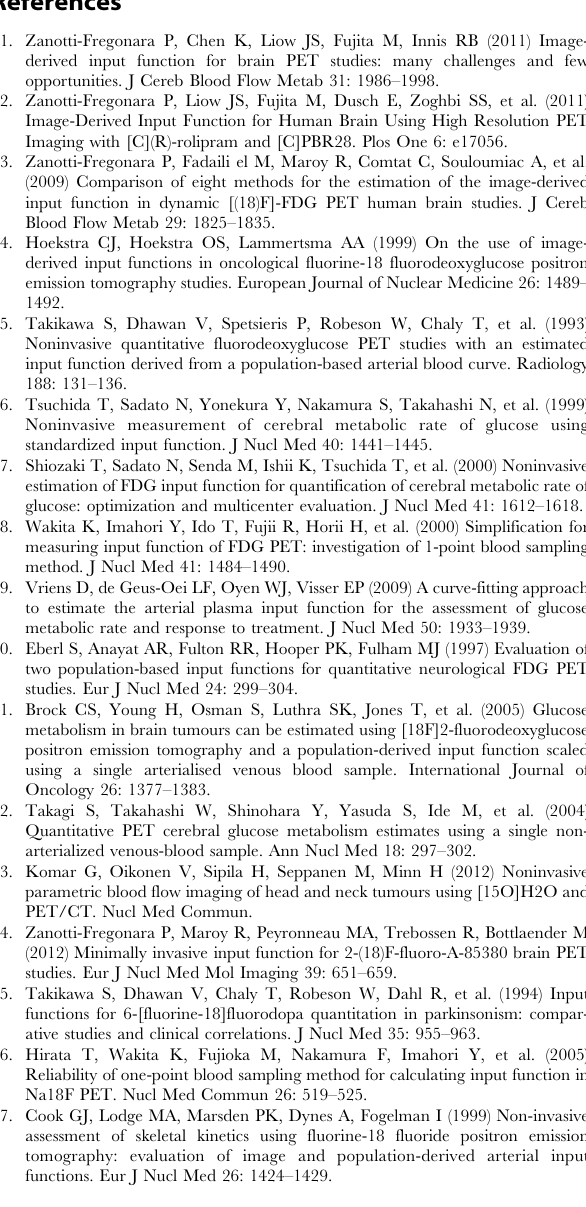
Table S1 Correlation coefficients for the area-under- the-curve of the plasma time-activity curve (AUC) using the measured radioligand